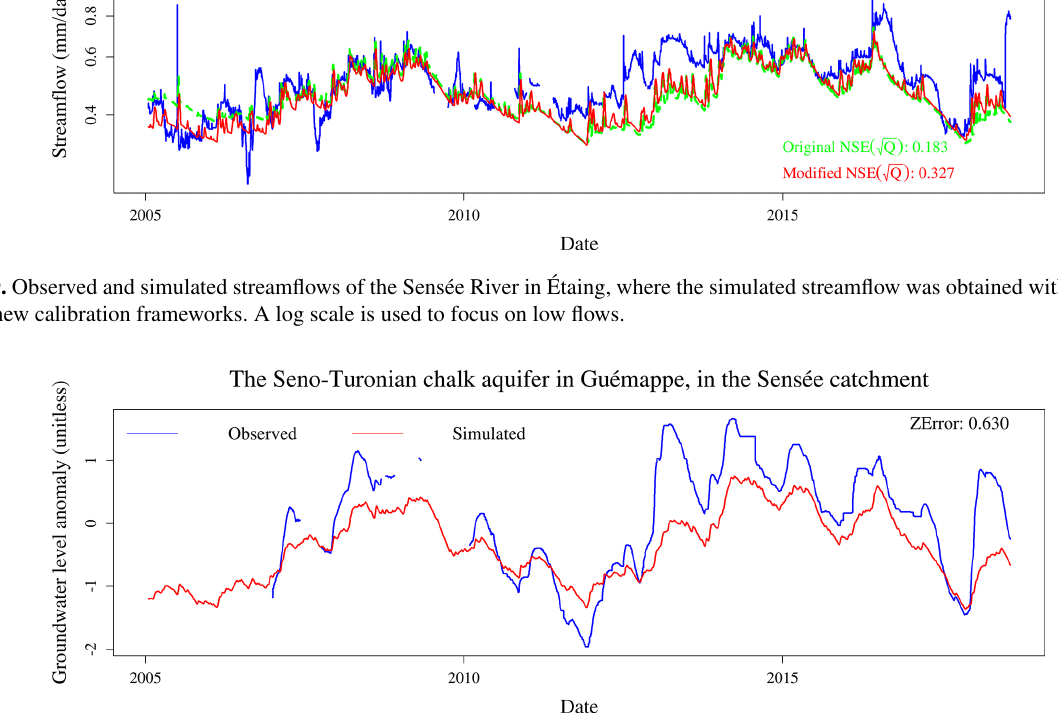
Figure 10. Observed and simulated groundwater levels in the Sensée catchment, where the simulated groundwater level was obtained with the new calibration frameworks.